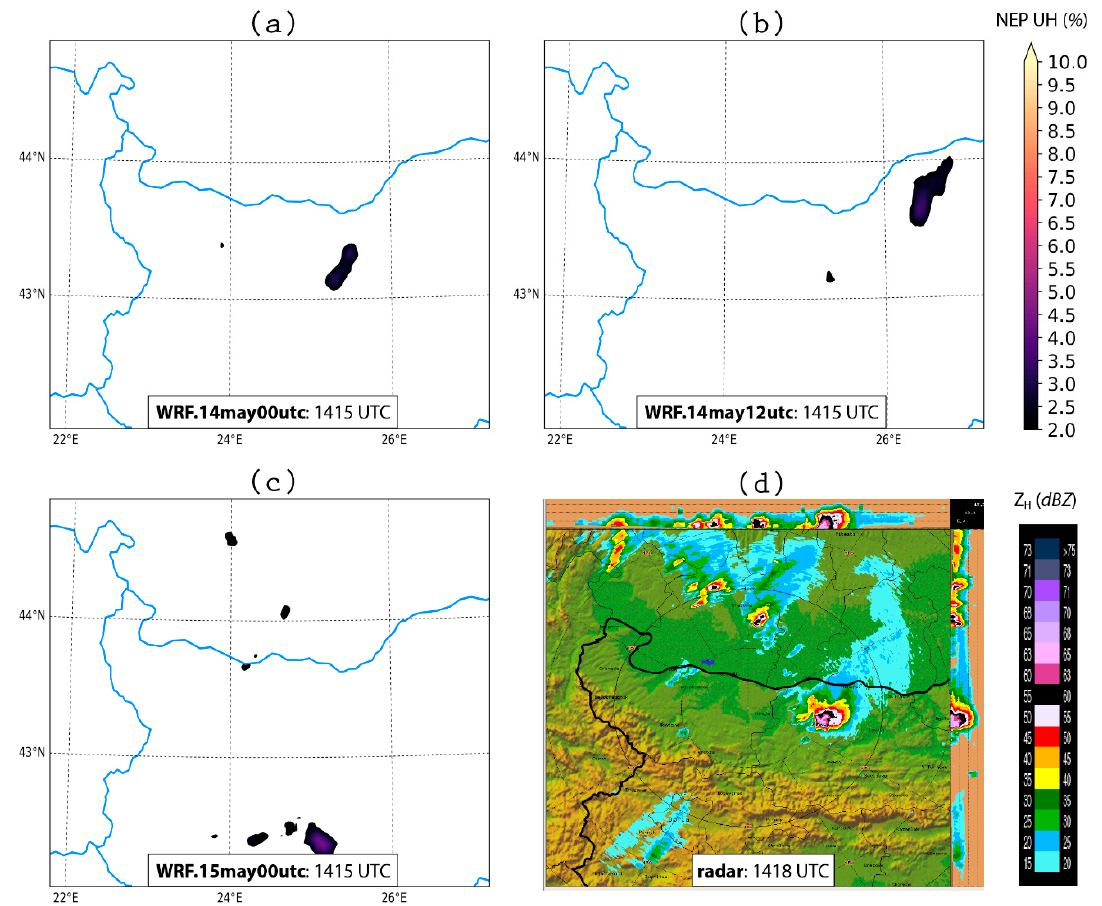
Figure 14. Forecasts of peak supercell intensity from ( a ) WRF.14may00utc, ( b ) WRF.14may12utc and ( c ) WRF.15may00utc at 14:15 UTC compared against ( d ) composite reflectivity observations at 14:18 UTC. Interpretation of the figures remains the same as in Figure 11.